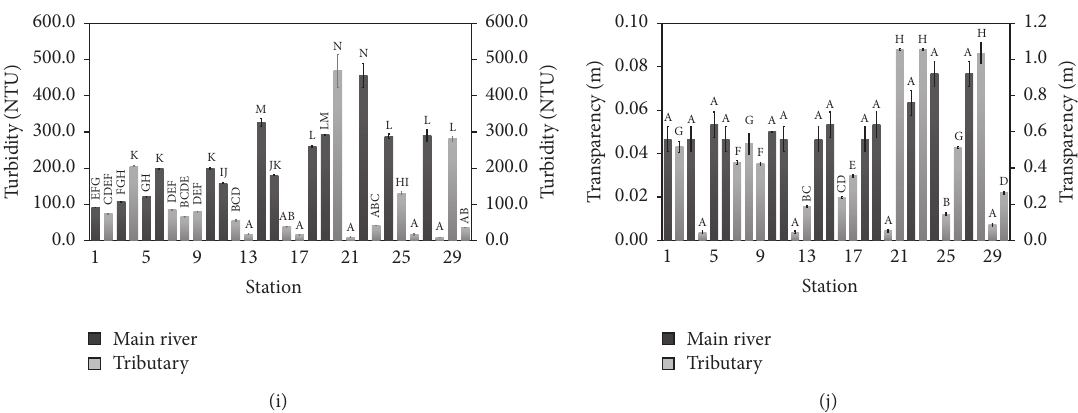
Figure 2: In situ parameters of (a) total discharge, (b) mean velocity, (c), mean depth, (d) temperature, (e) pH, (f) conductivity, (g) DOsat , (h) DO, (i) turbidity, and (j) transparency measured at the 30 sampling stations located along the Batang Baram (left axis) and its tributaries (right axis) (different letters indicate significant difference at 𝑝 value ≤